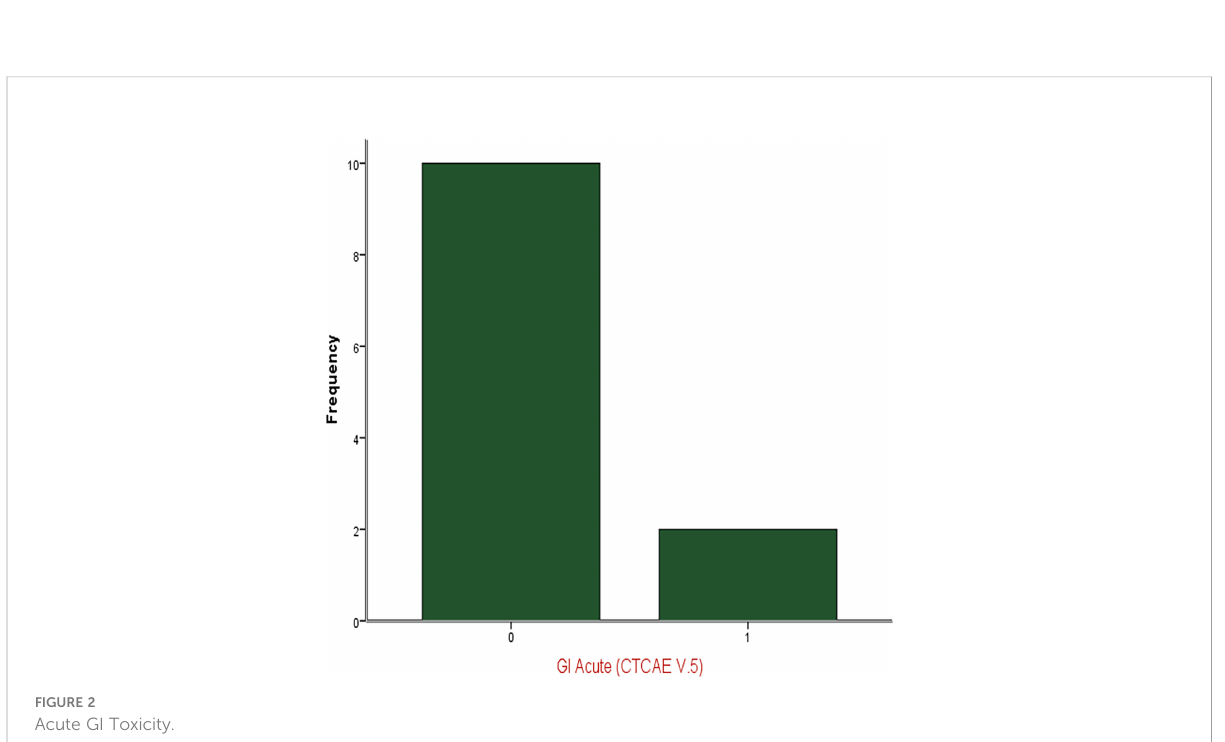
FIGURE 2 Acute GI